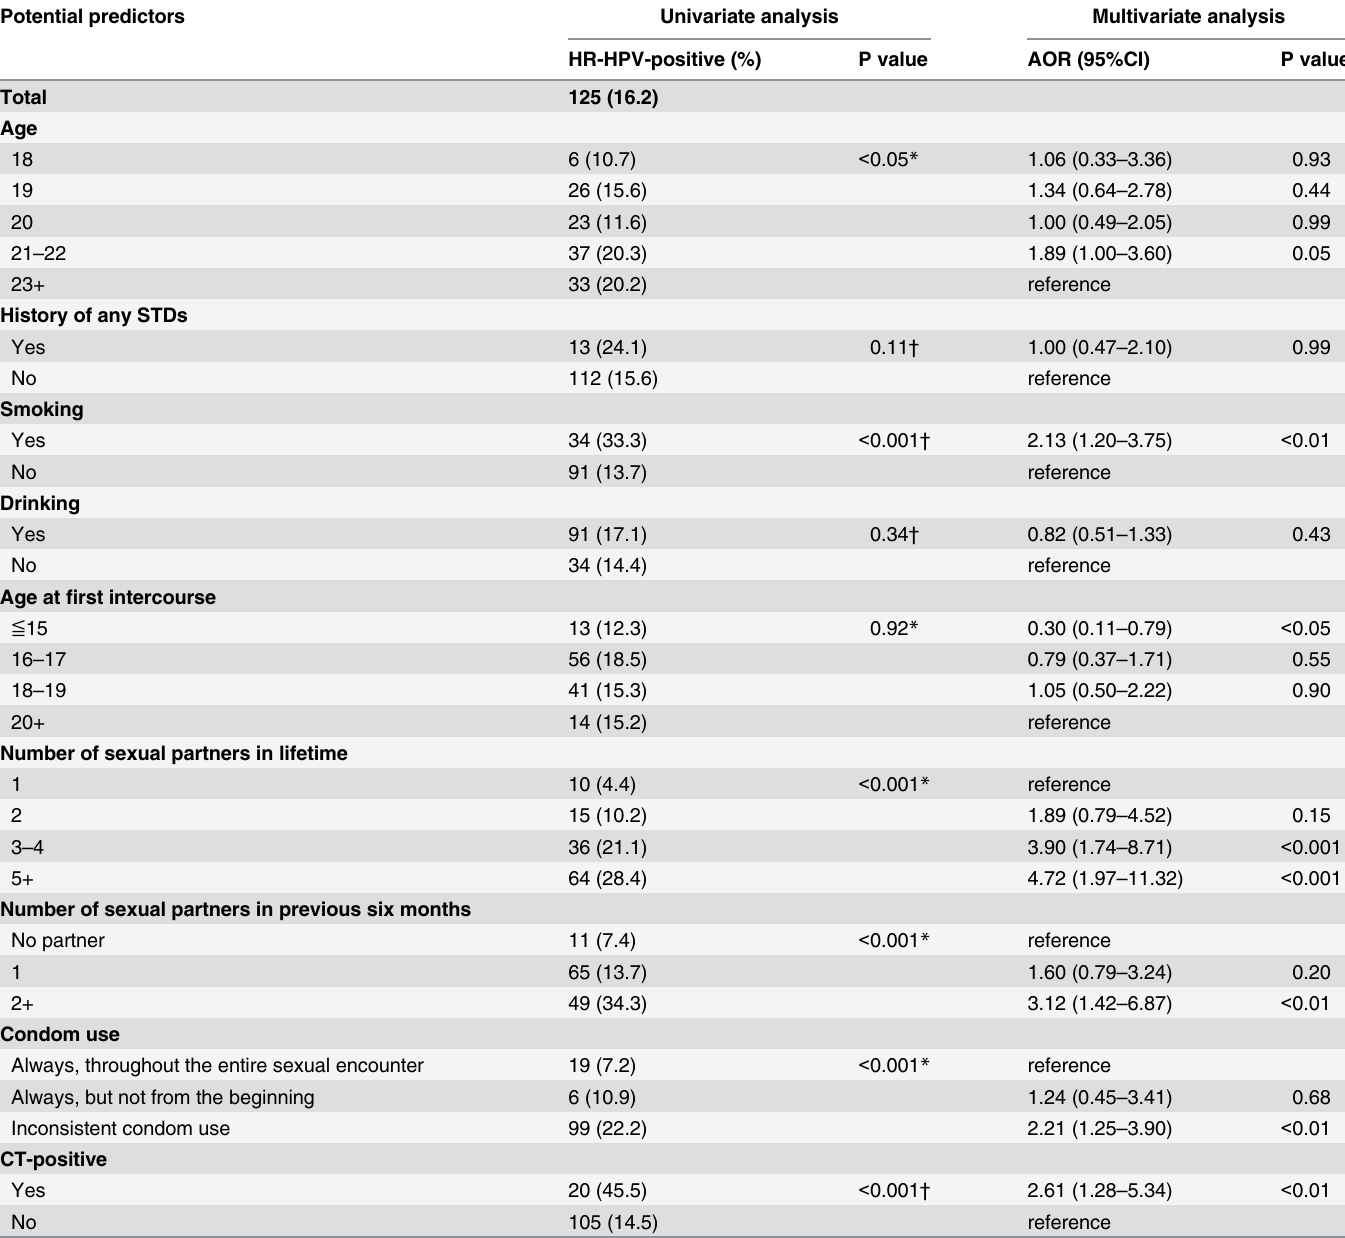
Table 2. Prevalence of HR-HPV infection, and univariate and multivariate logistic regression analyses of the association between potential predic- tors and HR-HPV infection in sexually active respondents (n = 770). Potential